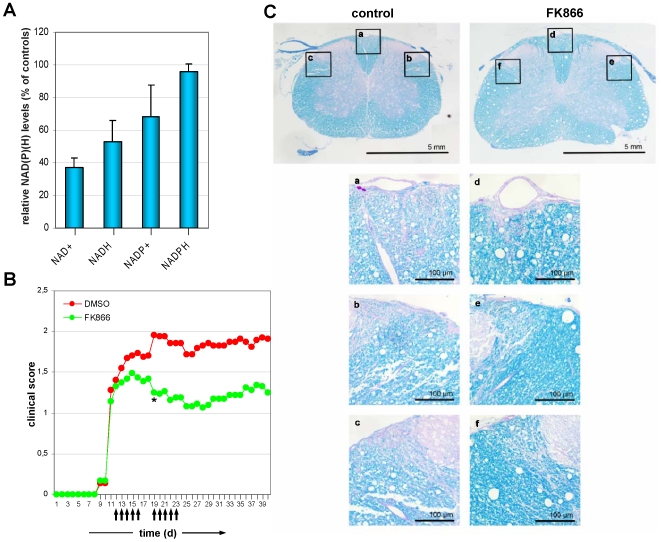
FK866 ameliorates EAE.10 mg/kg body weight FK866 were administered to mice from day 12 after rMOG immunization for 10 days. A, NAD(H) and NADP(H) levels were measured in mononuclear cells isolated from spleen and lymph nodes of treated or untreated animals at day 16. Dinucleotide levels in FK866-treated mice were expressed as % of those detected in control animals. B, FK866 halts EAE severity compared with controls (p<0.05 from day 19 onward). Arrows indicate the days of FK866 administration. C, Luxol fast Blue staining of the spinal cord shows areas of demyelination in control mice compared with FK866-treated animals.